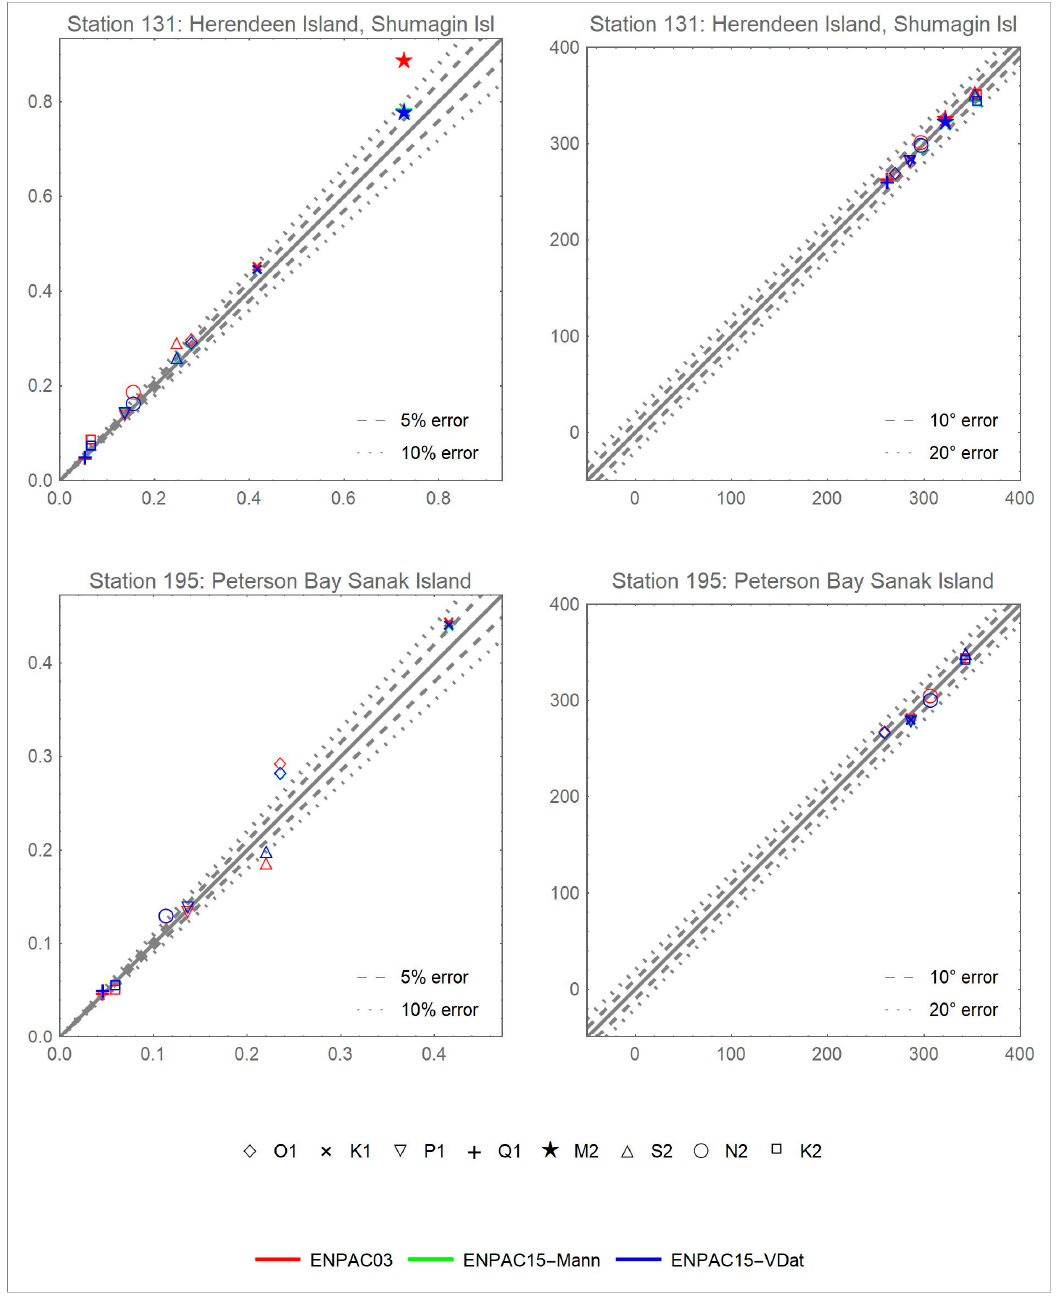
Figure A14. Scatterplots of errors for two Southern Alaska coast stations, locations shown in Figure